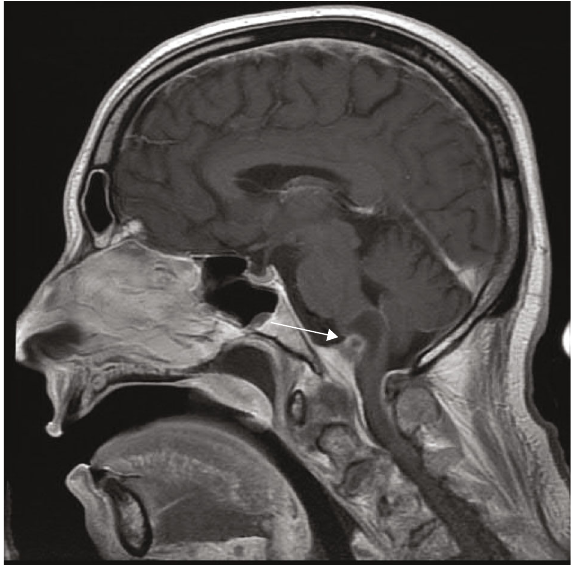
Figure 1: Preoperative MR brain T1-weighted sagittal image demonstrates a cystic mass arising at the C1-C2 level extending cephalad traversing the foramen magnum. The mass insinuates between the intradural segments of the vertebral arteries bilaterally causing severe compression at the cervicomedullary junction with the associated cystic area in the caudal medulla.